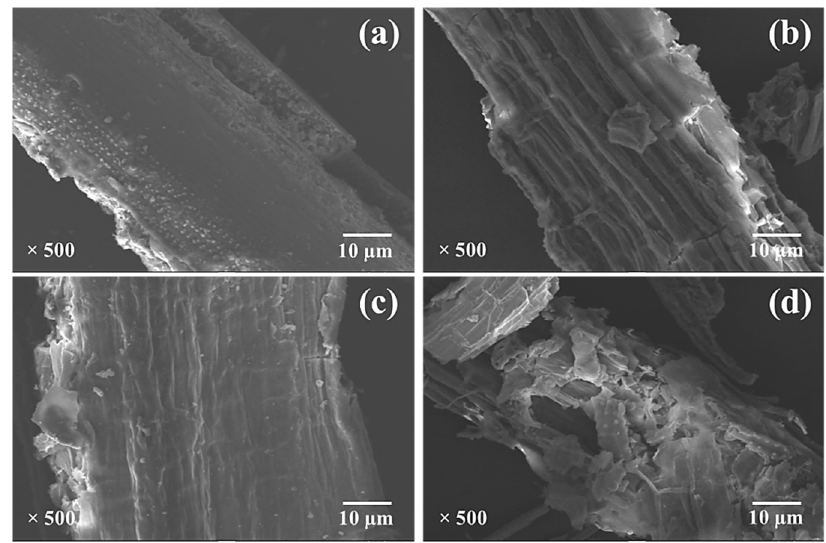
Figure 3. SEM images of untreated and pretreated rice straw. ( a ) Untreated rice straw, ( b ) laccase only, ( c ) laccase + [AMIM]Cl, ( d ) laccase + TritonX-100.